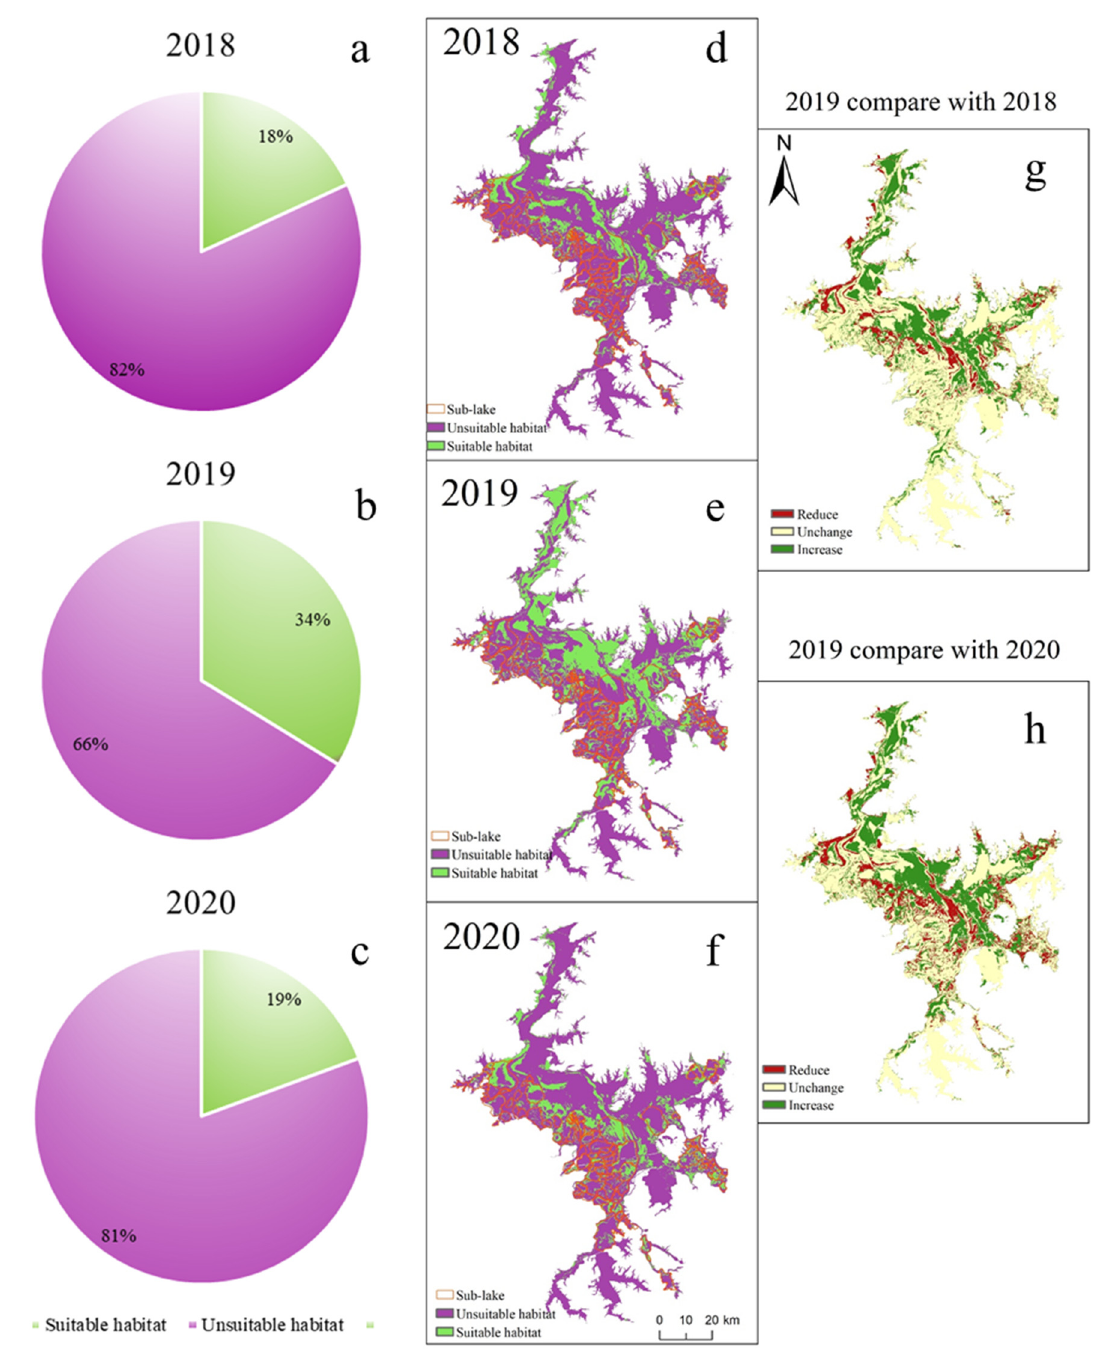
Figure 7. ( a – c ) Percentage of suitable habitat area for 2018 to 2020. ( d – f ) Spatiotemporal distribution of the suitable habitat from 2018 to 2020. ( g ) Suitable habitat spatiotemporal pattern changes from 2018 to 2019. ( h ) Suitable habitat spatiotemporal pattern changes from 2019 to